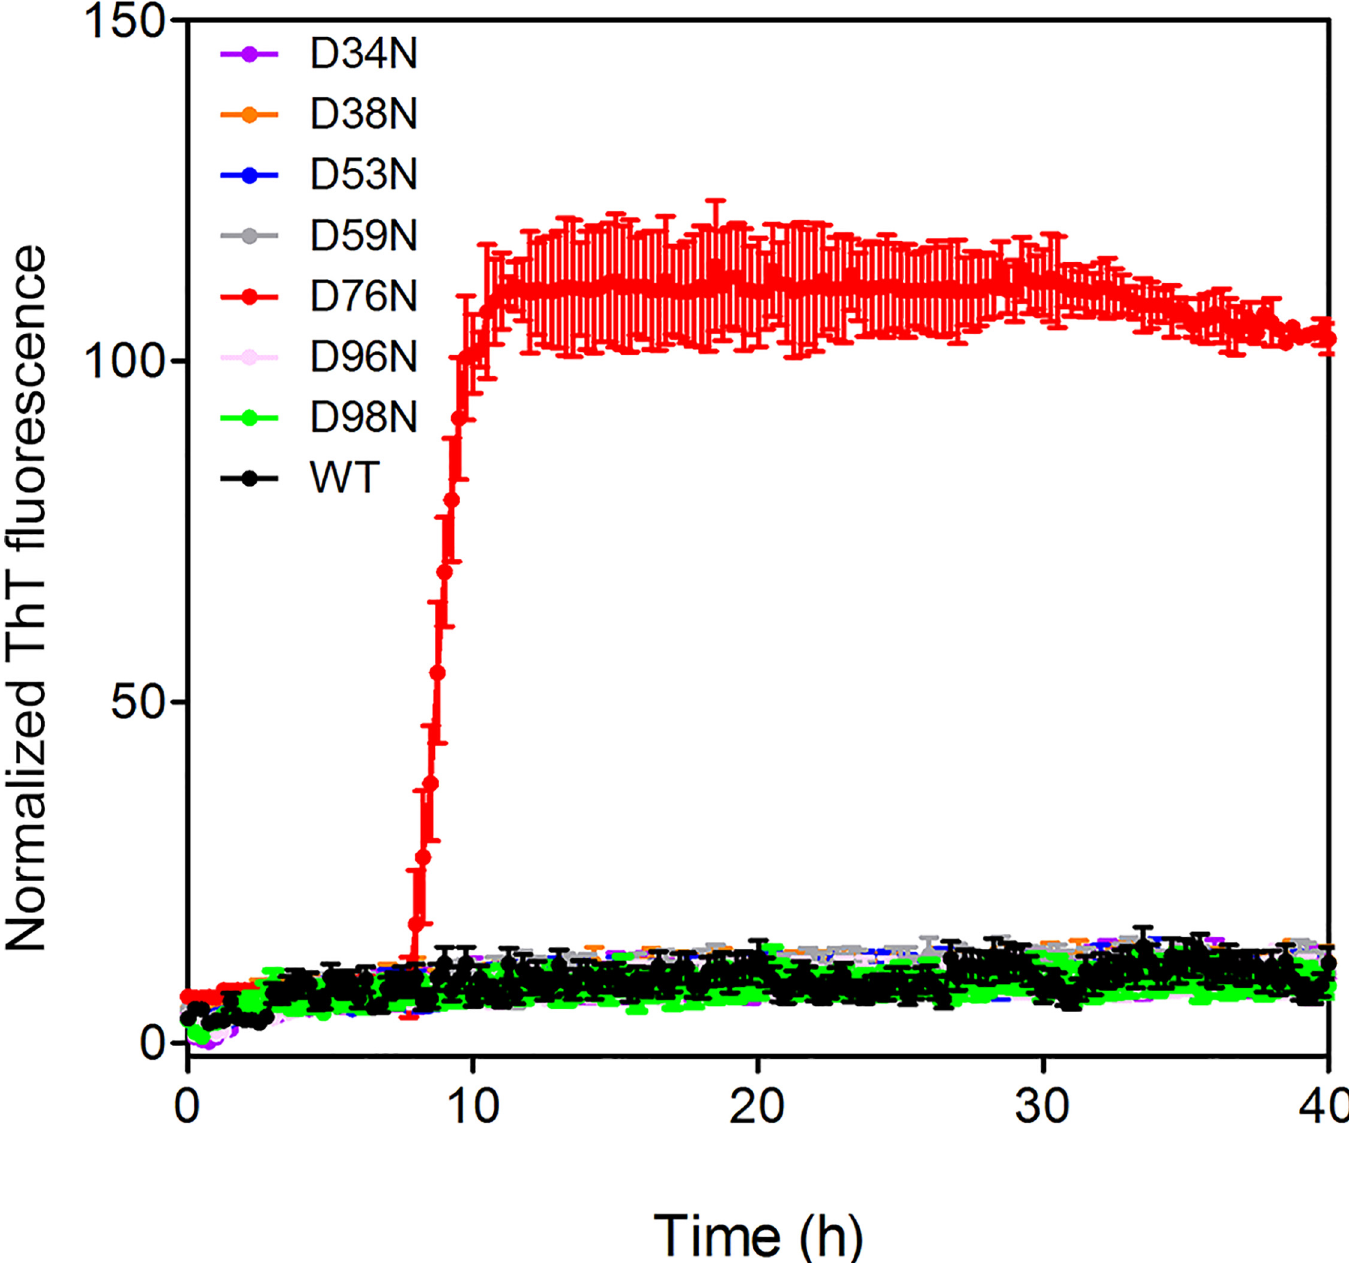
Fig 3. Aggregation of wt β 2m and of D-to-N variants. Under shaking conditions in physiological buffer, an increase of ThT signal was recorded solely for D76N β 2m (red), no signal increase was registered for the wt protein (black) or the other variants, whose signals are comprised in the base line: D34N (brown), D38N (orange), D53N (blue), D59N (grey), D96N (pink), D98N (green).